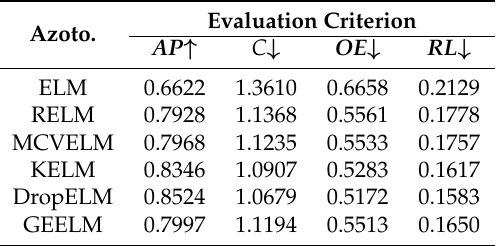
Table 9. The effectiveness comparison of ELM and its variants on the Azotobacter vinelandii dataset.